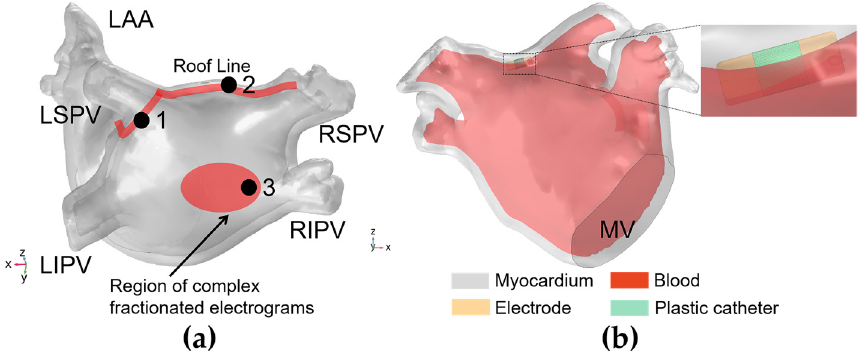
Figure 3. Ablation targets in the LA model and the ablation model. ( a ) Three representative ablation targets were selected based on the mainstream catheter ablation strategies for persistent AF in the LA model, corresponding to traditional pulmonary vein isolation (PVI) (ablation target 1), linear ablation (ablation target 2), and complex fractionated electrograms (CFAE) ablation (ablation target 3), respectively, where the LAA is the left atrial appendage, the LSPV/LIPV/RSPV/RIPV is the left superior/left inferior/right superior/right inferior pulmonary vein, and the MV is the mitral valve; ( b ) the ablation model where the catheter model is located at ablation target 2.